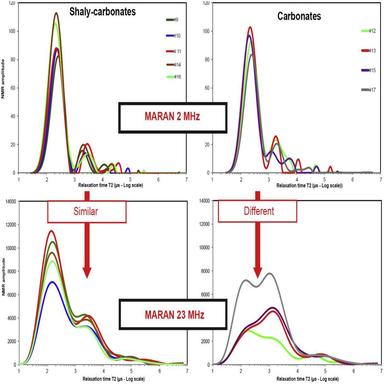
Pore distribution computed from spin-echo CPMG using Maran 2 MHz and 23 MHz spectrometers on preserved gas shales. Note the similar distributions in shaly-carbonates between both NMR spectrometers. The Maran 23 MHz records a different behaviour in the carbonates around T2 = 3 ms that we ascribe to water interactions with organic matter that improves the proton motion dynamics at the surface of organic matter.